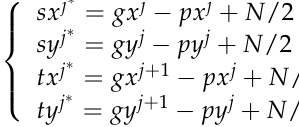
Table 2. The application flow of the learning-based planning method. Application Flow of Path